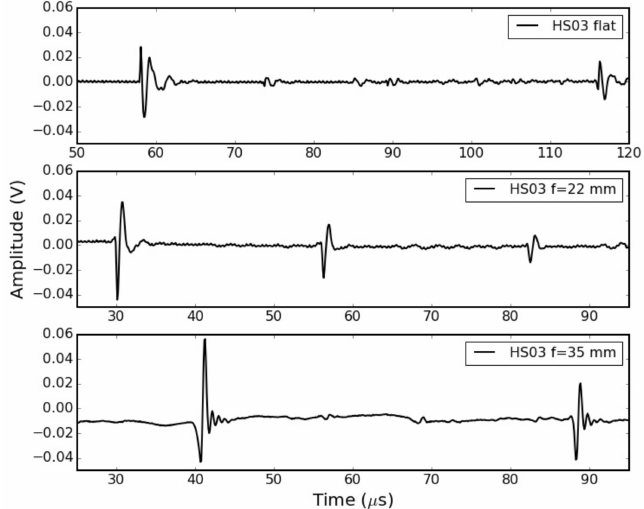
Figure 9. Response in the time domain in pulse-echo mode in water for the HS03 flat and focused transducers, radii of curvature of 22 and 35 mm.